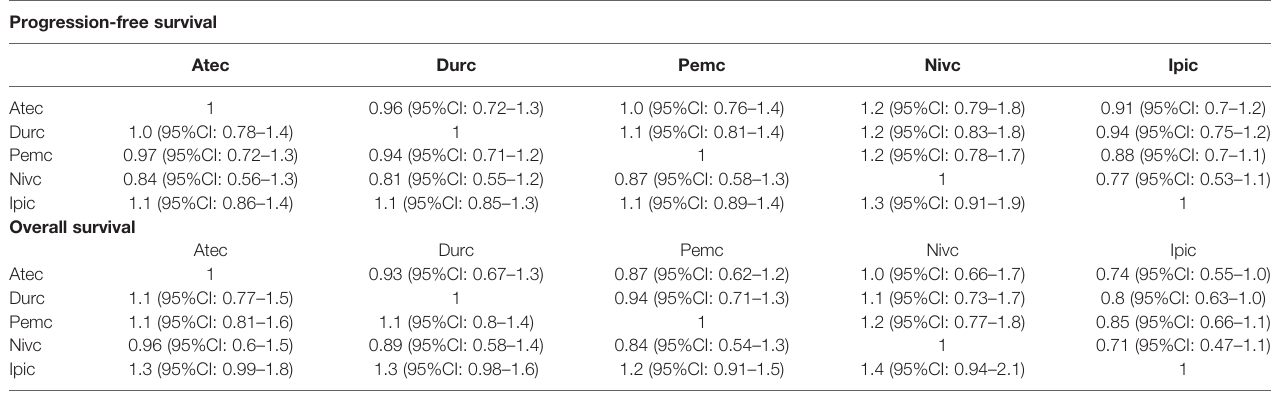
TABLE 2 | Hazard ratios (green cell) of the network meta-analysis of the progression-free survival and overall survival. Progression-free survival